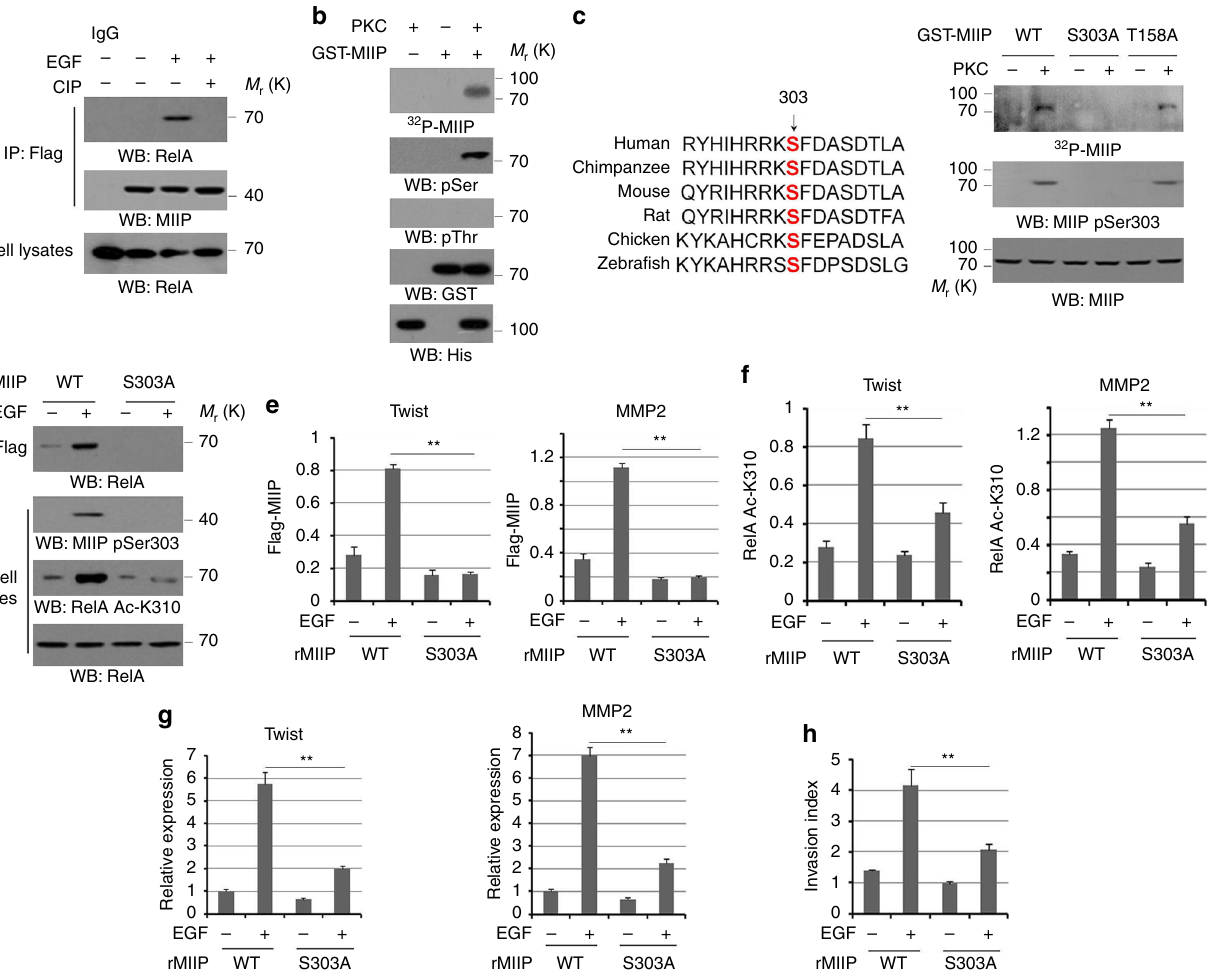
Fig. 2 PKC ε phosphorylated MIIP and promoted MIIP – RelA interaction. a HCT116 cells were treated with or without EGF. Cellular extracts subjected to immunoprecipitation with an anti-Flag antibody. The immunoprecipitates were treated with CIP (10 units), followed by immunoblotting analysis. b , c In vitro phosphorylation analyses were performed by mixing the puri fi ed active PKC ε with the indicated puri fi ed GST-MIIP proteins in the presence of [ γ -32P]ATP. Ser303 of MIIP is evolutionarily conserved in the indicated species ( c , left panel). d HCT116 cells expressed with WT MIIP or MIIP S303A were treated with or without EGF for 30min. e HCT116 cells expressed with WT MIIP or MIIP S303A were treated with or without EGF (100 ng/ml) for 10h. f HCT116 cells with depletion of MIIP, and reconstituted expression of WT rMIIP or rMIIP S303A were treated with or without EGF (100ng/ml) for 10h. g HCT116 cells with depletion of MIIP, and reconstituted expression of WT rMIIP or rMIIP S303A were treated with or without EGF for 10h. Relative mRNA levels were analyzed by q-PCR. h HCT116 cells with depletion of MIIP, and reconstituted expression of WT rMIIP or rMIIP S303A were treated with or without EGF (100 ng/ml). Cell invasion assays were performed. In e , f , ChIP analyses with indicated antibodies were performed. The primers covering RelA binding site of MMP2 gene promoter region were used for the q-PCR. The Y axis shows the value normalized to the input. In a – d , immunoblotting analyses were performed using the indicated antibodies. In e – h , the values are presented as mean ± s.e.m. ( n = 3 independent experiments), ** represents P < 0.01 (Student ’ s t -test) between the indicated